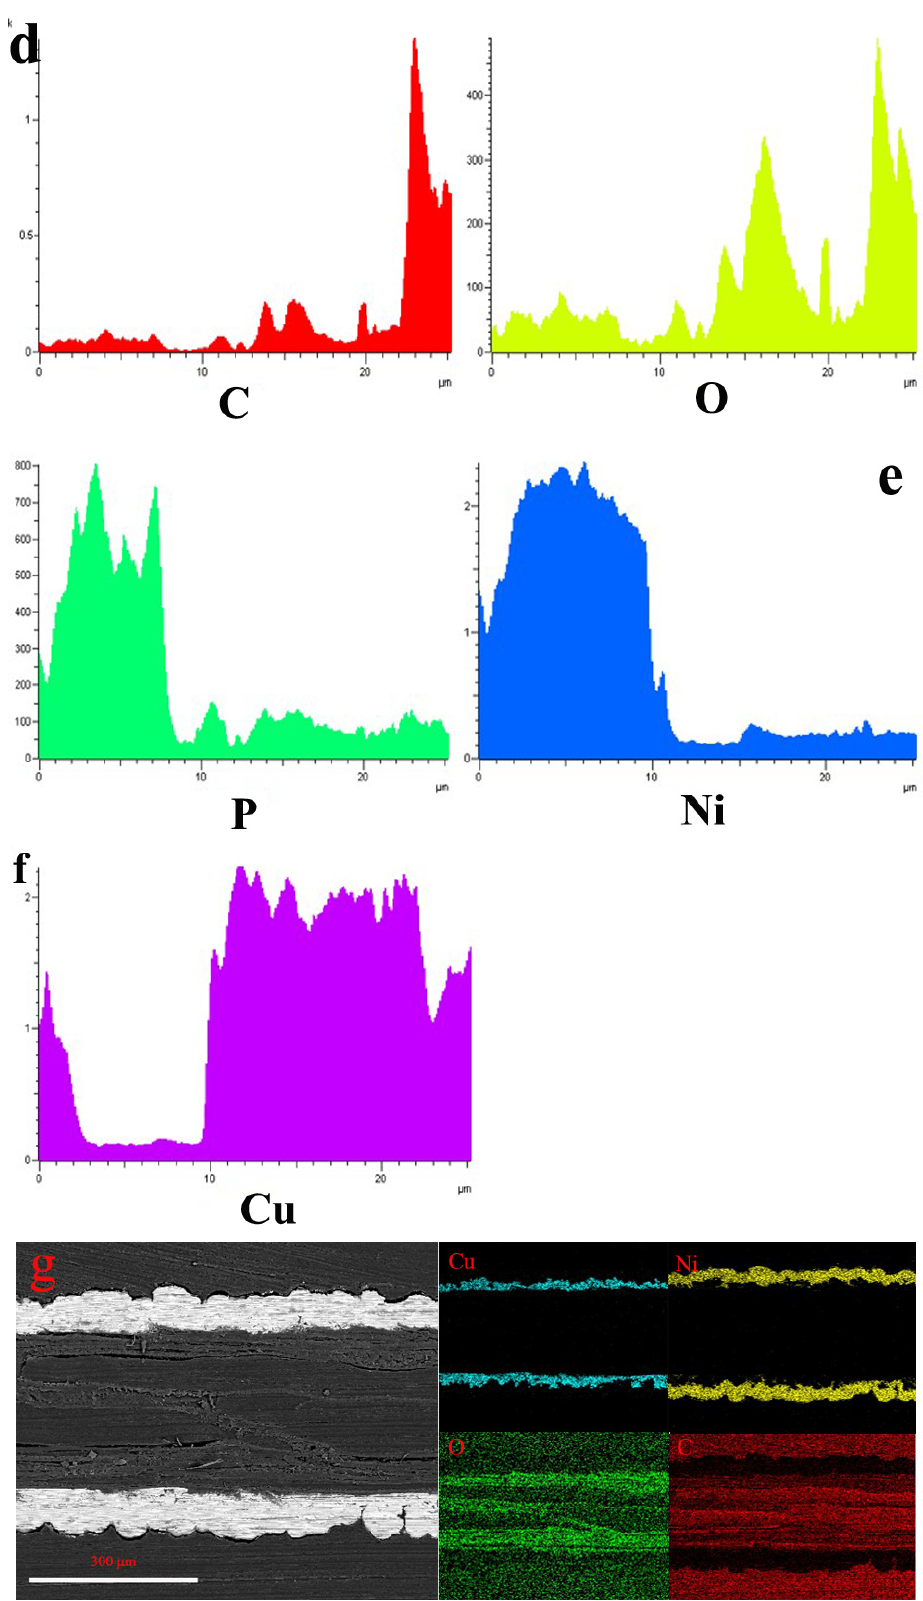
Figure 2. Cross-section morphology ( a ) surface morphology, inset shows EDS images; ( b ) interface morphology; ( c ) interface morphology; ( d ) C and O elements; ( e ) P and Ni elements; ( f ) Cu element; ( g ) interface morphology and element composition distribution.